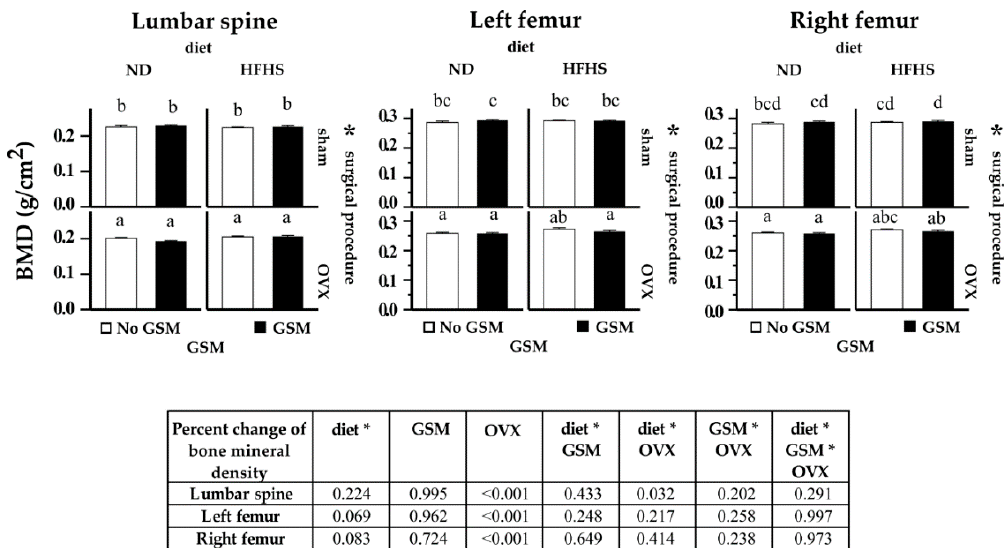
Figure 2. Bone mineral density in lumber spine and femur (each group n = 11–12). Bone mineral density (BMD) was evaluated using dual energy X-ray absorptiometry at the end of the study (age 48 weeks). Bar graphs and error bars show means and SE respectively. Two-way ANOVA was used to evaluate the influence of e ff ects; diet, surgical procedure, and GSM. If the e ff ect was statistically significant, the asterisk * is indicated. One-way ANOVA was used to identify significant di ff erences across all groups. In case data reached the criteria, a multiple comparison test is performed using Turkey method, and then letters are indicated on the bar. Groups showing di ff erent letters are significant di ff erences. Table in the figure shows p values calculated from two-way ANOVA analysis. p values less than 0.05